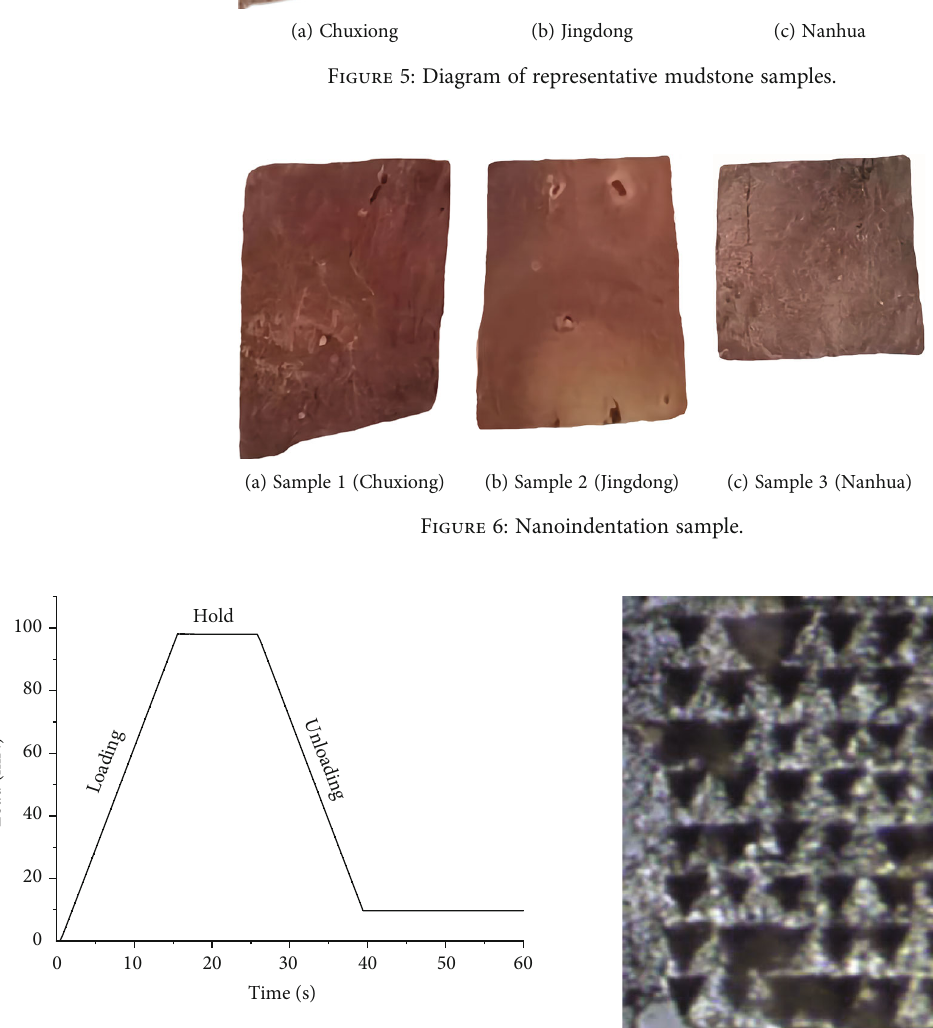
Figure 7: Load-time curve of